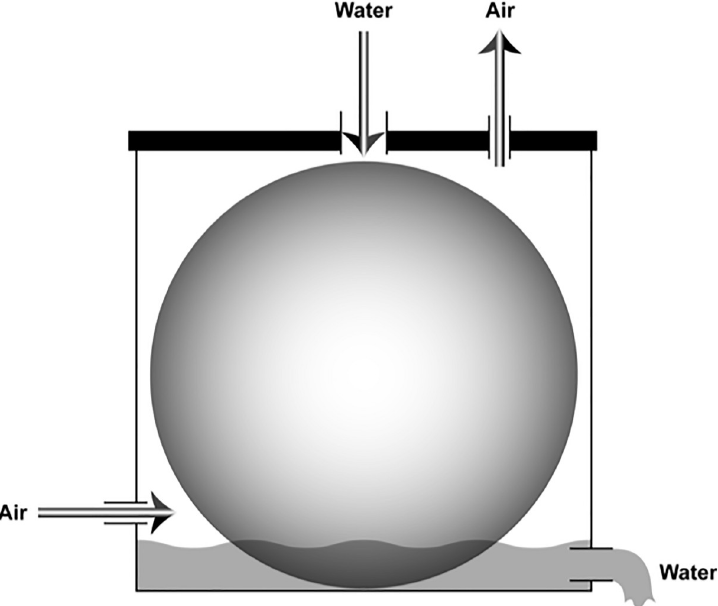
Fig 1. Spherical falling film equilibrator diagram. Water is pumped through the roof of the chamber and directly onto the topmost point of sphere. The water forms a falling film that coats the sphere and creates a gas exchange surface. Water releases from the sphere at the water line below, where it drains out of the chamber. Air enters the lower part of the chamber, flows upward, counter-current to the water flow, and exits out the roof of the chamber. Air is circulated in a closed loop from the EQL to a sensor and back into the bottom of the